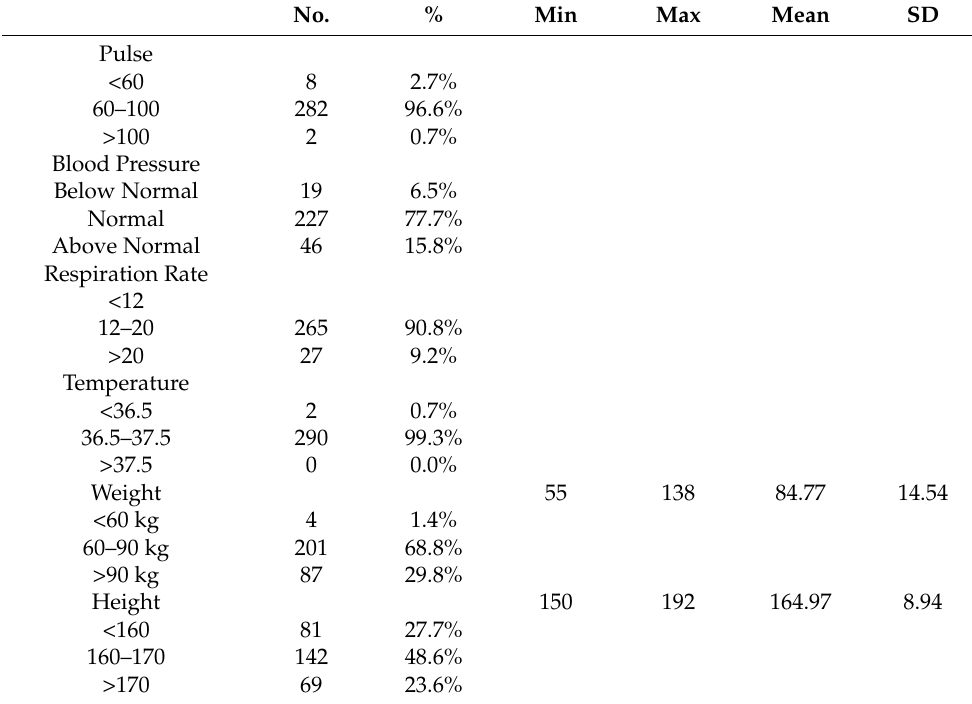
Table 3. Distribution of the subjects according to their physical examination.